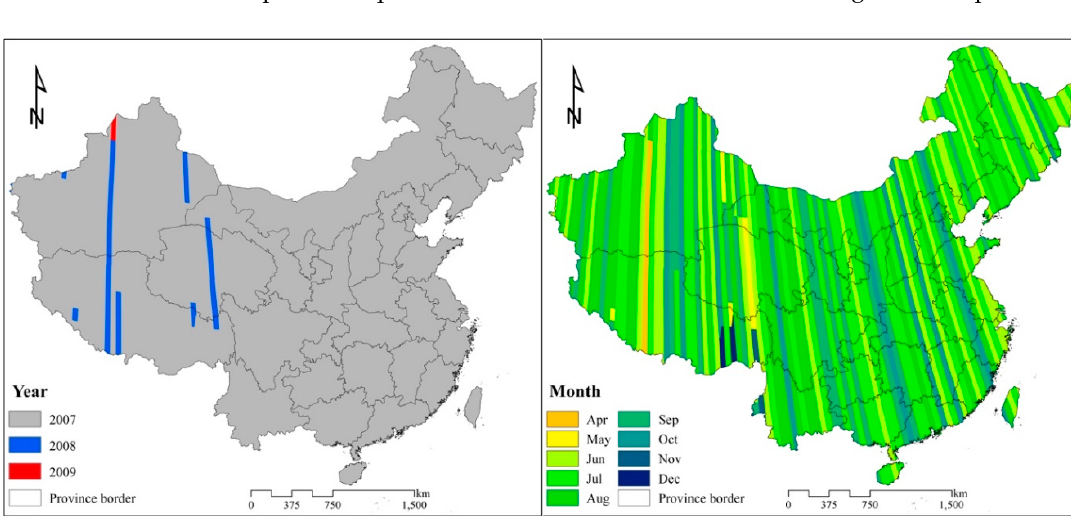
Figure 1. Date acquisition of Phased Array L-band Synthetic Aperture Radar (PALSAR) mosaic dataset in China in 2007, including years ( left ) and months ( right ).